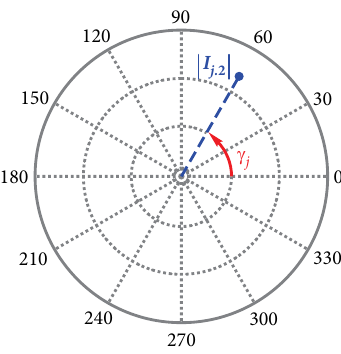
| and g in the polar coordinate system j. 2 j